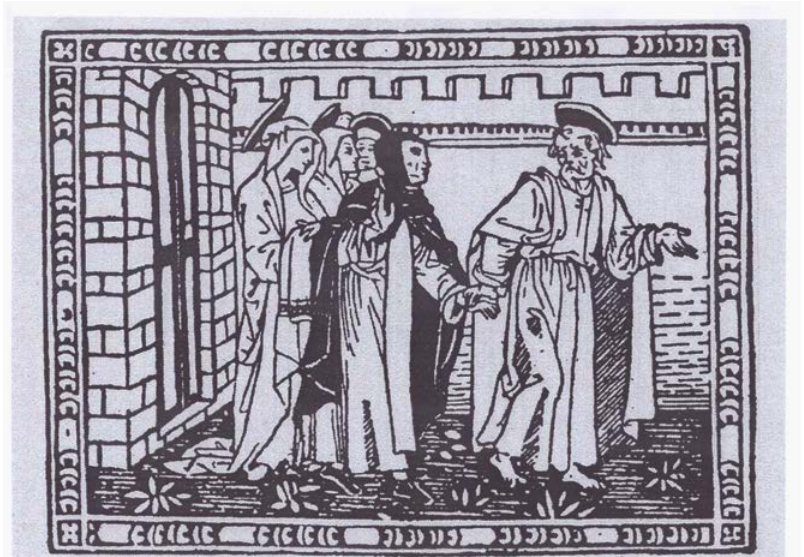
Figure 12 – Girolamo Savonarola, Compendio di rivelatione , ad instantia di ser Piero Pacini da Pescia, Firenze 23 aprile 1496, f. 32r (BNCF, Sav. 146). By permission of Ministero per i beni e le attività culturali / Biblioteca Nazionale Centrale.